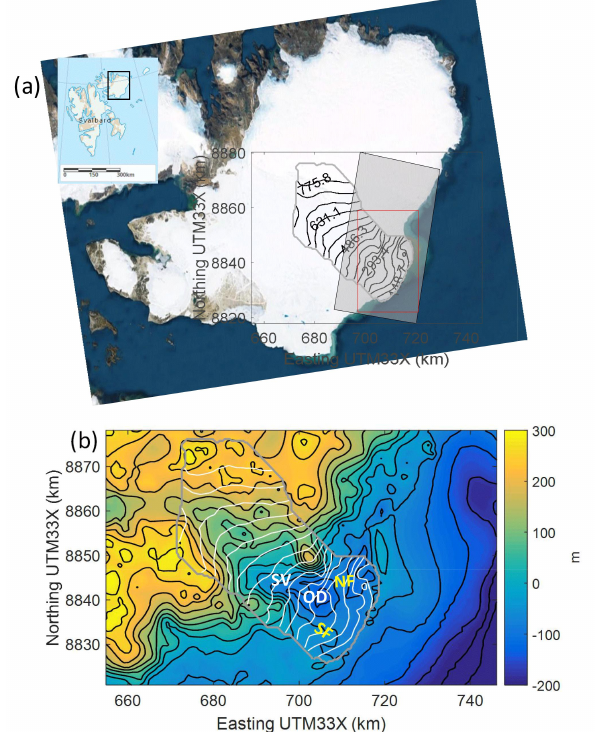
Figure 1. Surface and bedrock topography of Basin 3, Austfonna. (a) Surface elevation contours with solid black lines (with ∼ 48.2m interval), on top of a satellite image of Nordaustlandet from TerraColor ® Global Satellite Imagery (http://www.terracolor.net/). The grey transparent box shows the coverage of the TerraSAR-X scene (30 April 2012). The model domain of HiDEM is outlined with a red box. The insert at the upper-left corner shows the ice cap’s location within the Svalbard archipelago. (b) Bedrock topography is colour-coded, contoured with black solid line with a ∼ 37.1m in- terval and superimposed by surface elevation contours (white solid line with ∼ 48.2m interval). The grey solid line outlines Basin 3 and the model domain of Elmer/Ice in both panels. “SV” marks the subglacial valley that runs between two bedrock maxima in the north-east and south-west and extends several tens of kilometres up- stream and downstream. “OD” marks the minimum bedrock height for Basin 3 and is within an overdeepening in the lower part of the valley. “NF” marks the downstream area of the northern flow unit of the glacier, which runs from upstream of the valley and exits from the northern terminus. The alignment of these labels roughly indi- cates the flow direction. Similarly, “SF” marks the downstream area of the southern flow